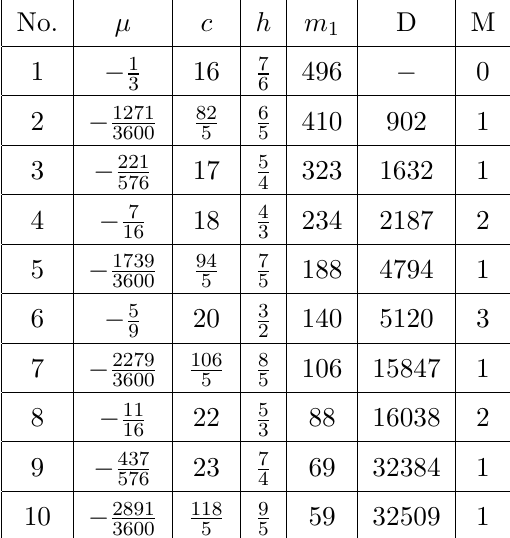
Table 2 . Consistent CFT’s with ‘ =